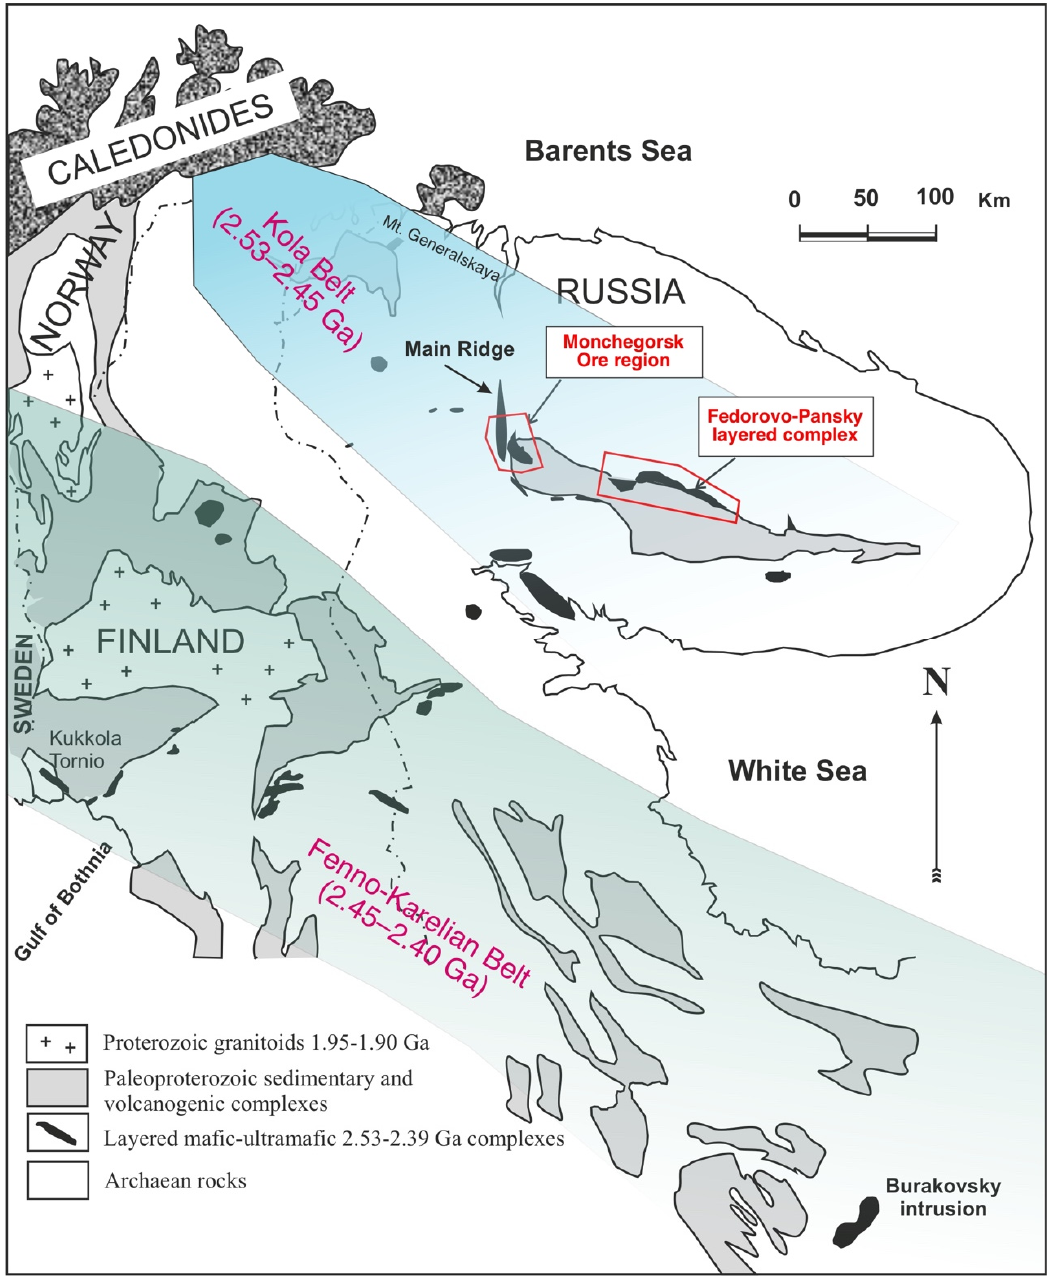
Figure 1. Schematic geological map of the northeastern part of the Fennoscandian Shield and the location of Paleoproterozoic mafic-layered intrusions (modified after [12]). The red frames show the studied ore areas.